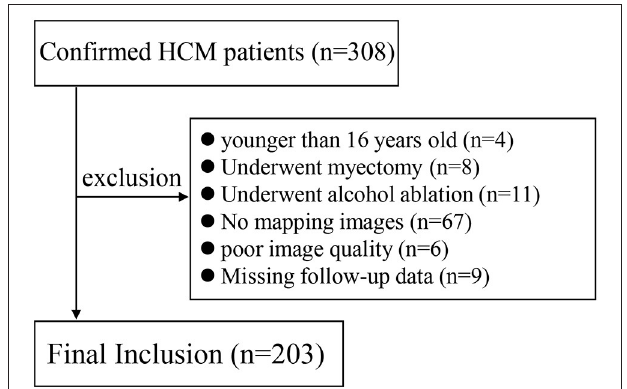
FIGURE 1 | Flow diagram of patient